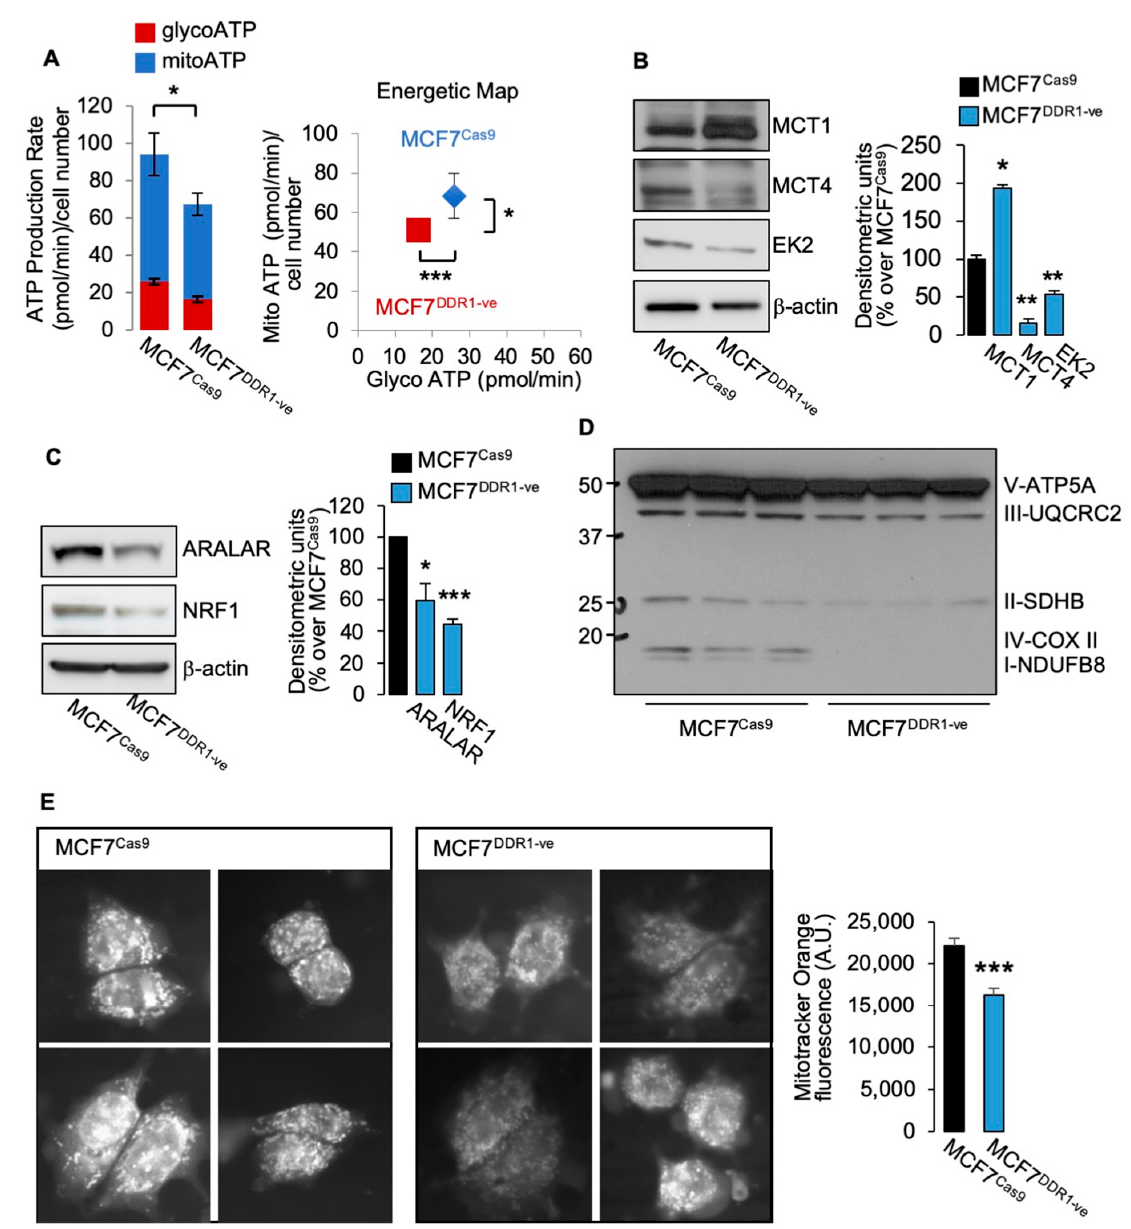
Figure 4. ( A ) MCF7 DDR1-ve cells and parental (MCF7 CAS9 cells were subjected to real time cell bioenergetics (Agilent ATP test). Values are means ± SEM of three separate experiments, which are compared with the Student’s t -test. ( B – D ) The same cells as in (A) were grown in 10% FBS, lysed, and analyzed by SDS-PAGE and immunoblot for the indicated proteins. β -actin antibody was used as control for protein loading. A representative blot of three independent experiments is shown. Graphs show the mean ± SEM of densitometric analysis of three independent experiments that are compared with the Student’s t-test. ( E ) Mitochondrial activity was evaluated in MCF7 DDR1-ve cells and parental MCF7 CAS9 by immunofluorescence using the probe MitoTracker Orange. Four representative images are shown for each cell line. Graphs represent the mean ± SEM of densitometric analysis of three independent experiments that are compared with the Mann–Whitney test. (ns—not significant; * p < 0.05; ** p < 0.01; *** p < 0.001).